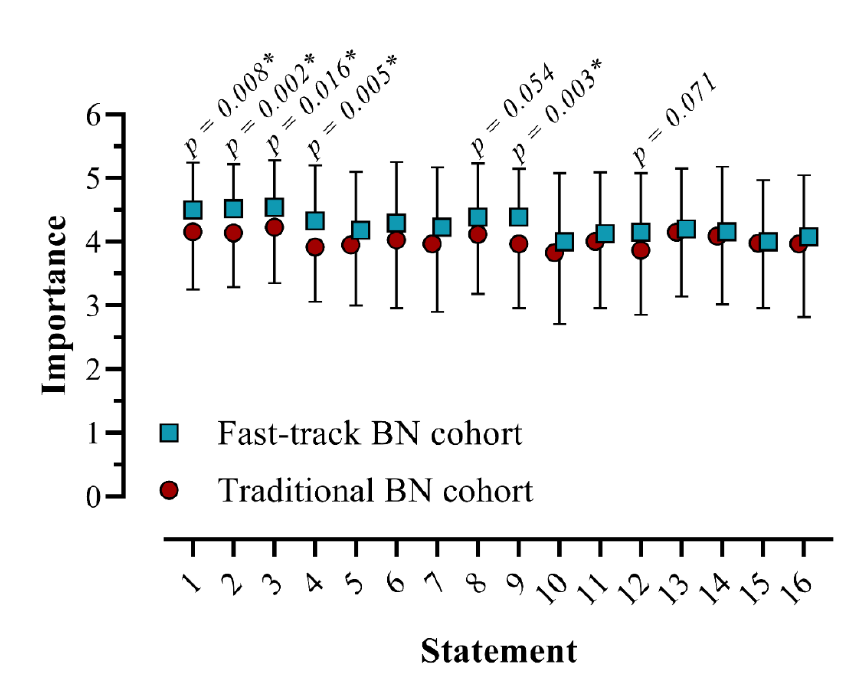
Figure 2 Agreement Scores in Response to each Survey Statement for both Student